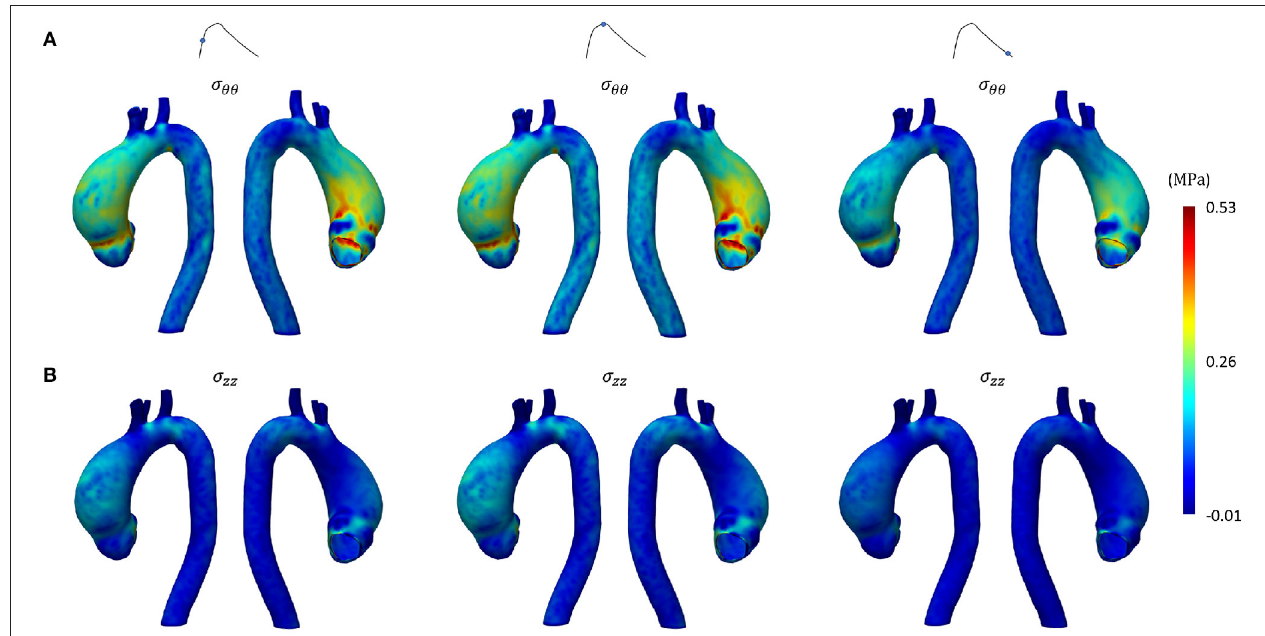
FIGURE 8 | Structural results from SOL FSI SD step at early systole, peak systole and late diastole in terms of (A) circumferential and (B) longitudinal stress.